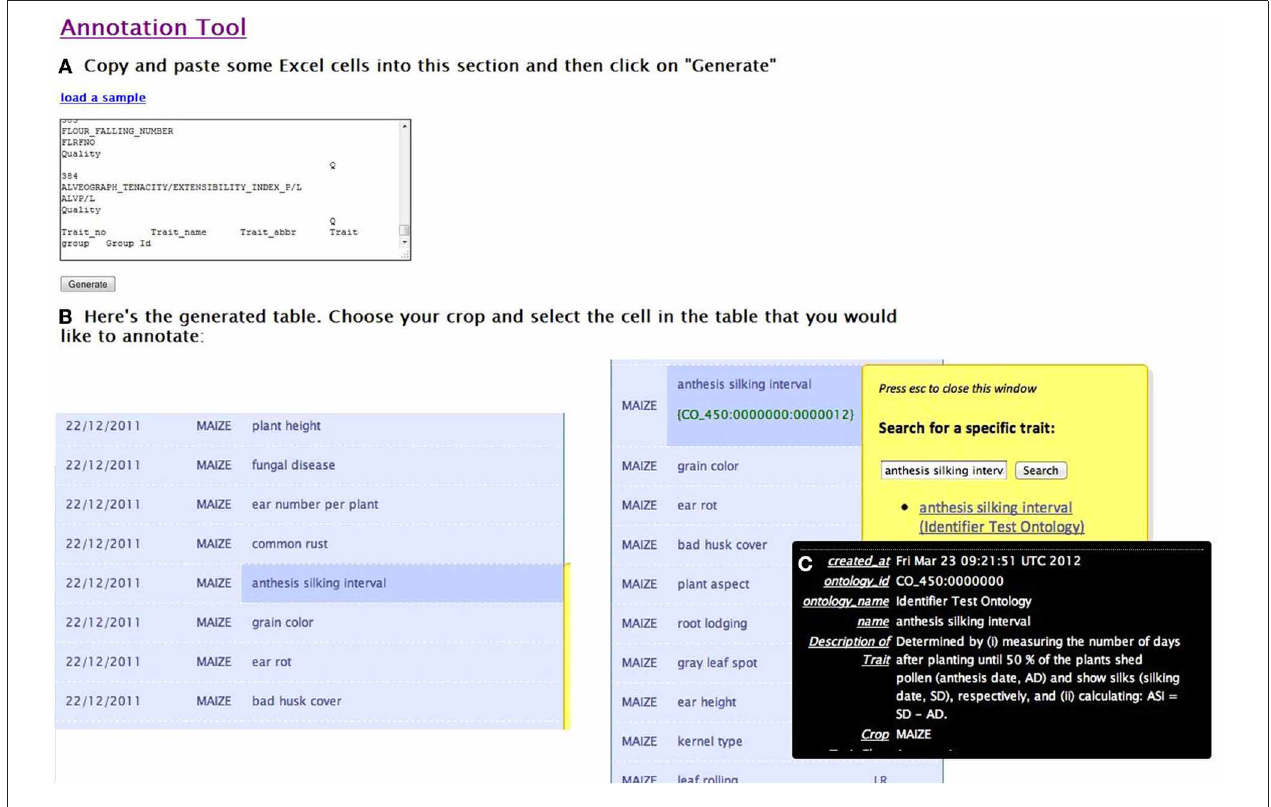
FIGURE 7 | Screenshotoftheonlineannotationtoolshowingstepsinthe annotationprocess:(A)pastedataormetadatatoannotate(B)thetool generatesatableandusercanselectoneontology(e.g.,maizetrait)before